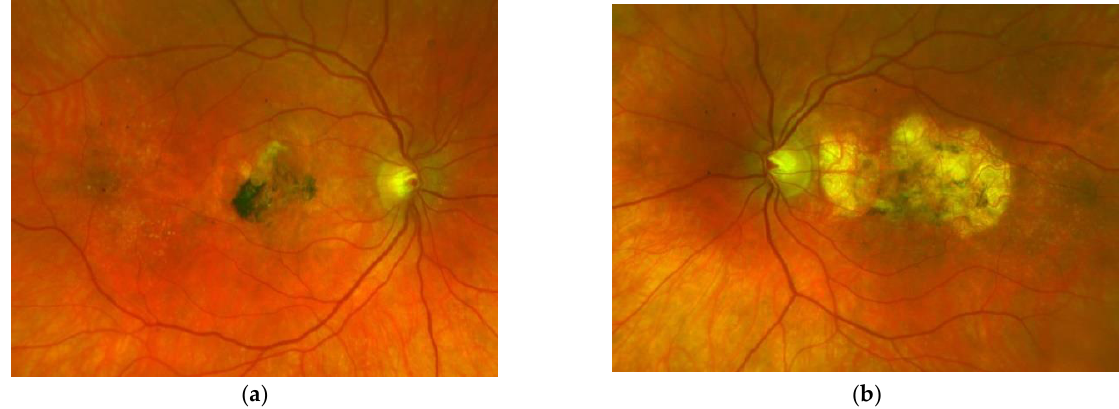
Figure 3. Same patient, 2016, 10 years after the start of intravitreal therapy; no lesion activity after 22 intravitreal Ranibizumab injections in the right eye ( a ) and a remarkable progressive macular atrophy despite a stable scar in his left eye ( b ).